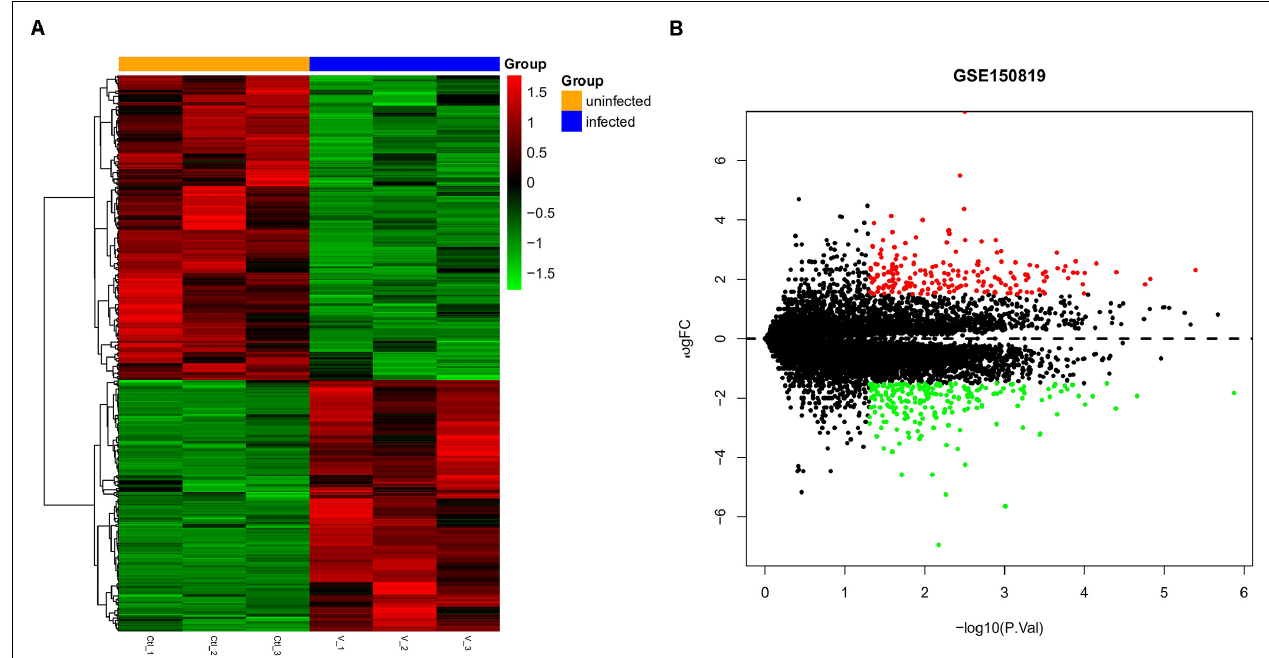
FIGURE 1 | Visual expression of DEGs in GSE150819. (A) The heatmap of DEGSs. (B) The volcano plot of DEGs. Red and green represent relative upregulation and downregulation of gene expression, respectively.